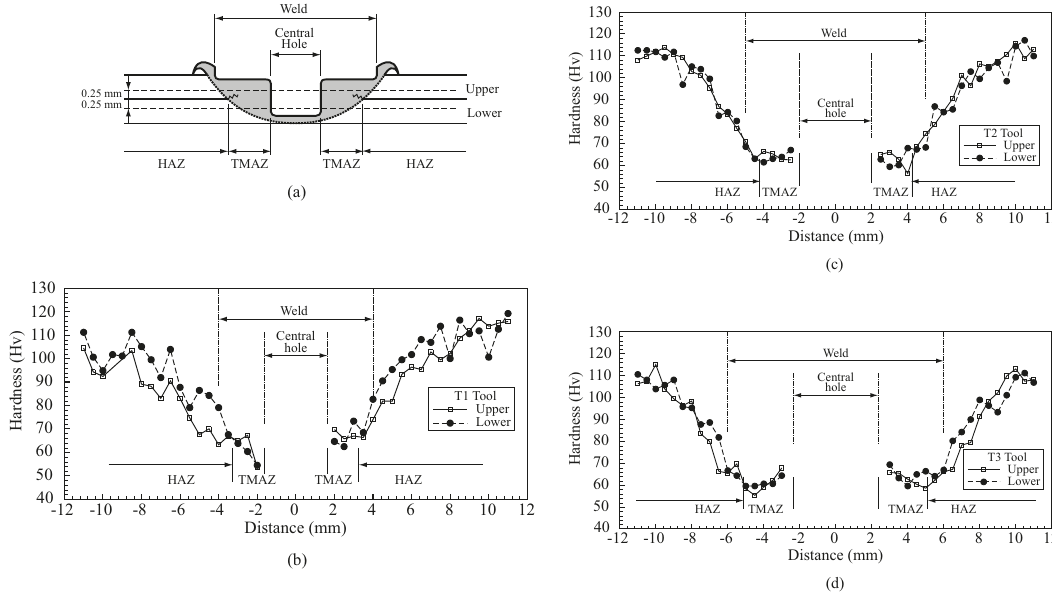
Figure 11. ( a ) A schematic plot of two horizontal lines for micro-indentations on the cross section of a FSSW; ( b – d ) Micro-hardness distributions for FSSWs made by T1, T2 and T3 tools, respectively.